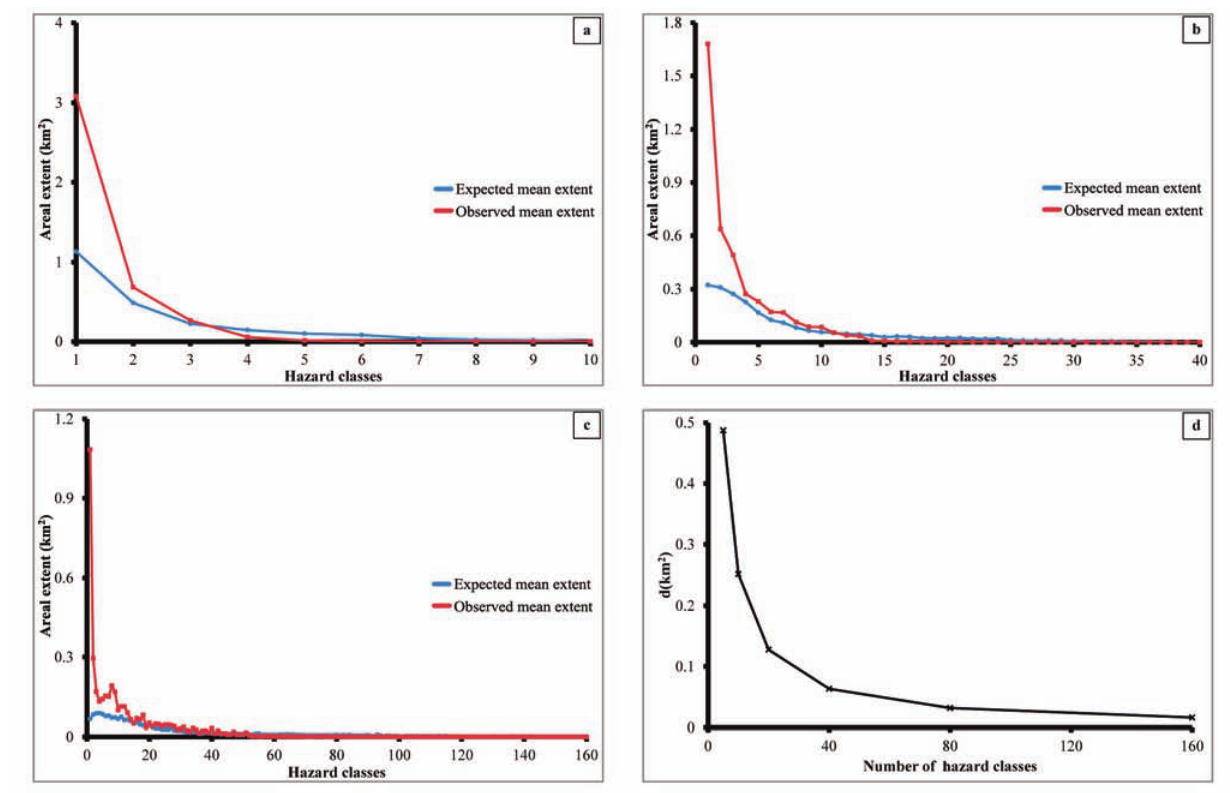
Figure 6. (a-c) Comparison between the observed and expected mean extents of the areas affected by the 13 historical lava flows considered and simulated on the present-day topography, with respect to the lava-invasion hazard map with 10, 40 and 160 classes, respectively; (d) Trend of the mean distance between the observed and expected affected areas, d , with respect to the number of classes, showing considerable convergence for high-density classed maps. The fitting is satisfied starting from d = 0.25 km 2 , which is obtained in correspondence with the 10-classed hazard